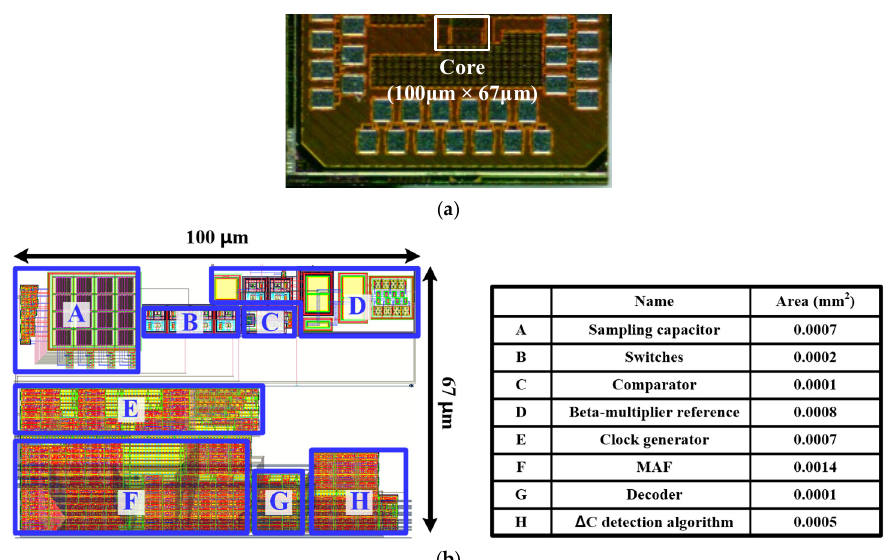
Figure 6. ( a ) Chip microphotograph; ( b ) core layout.